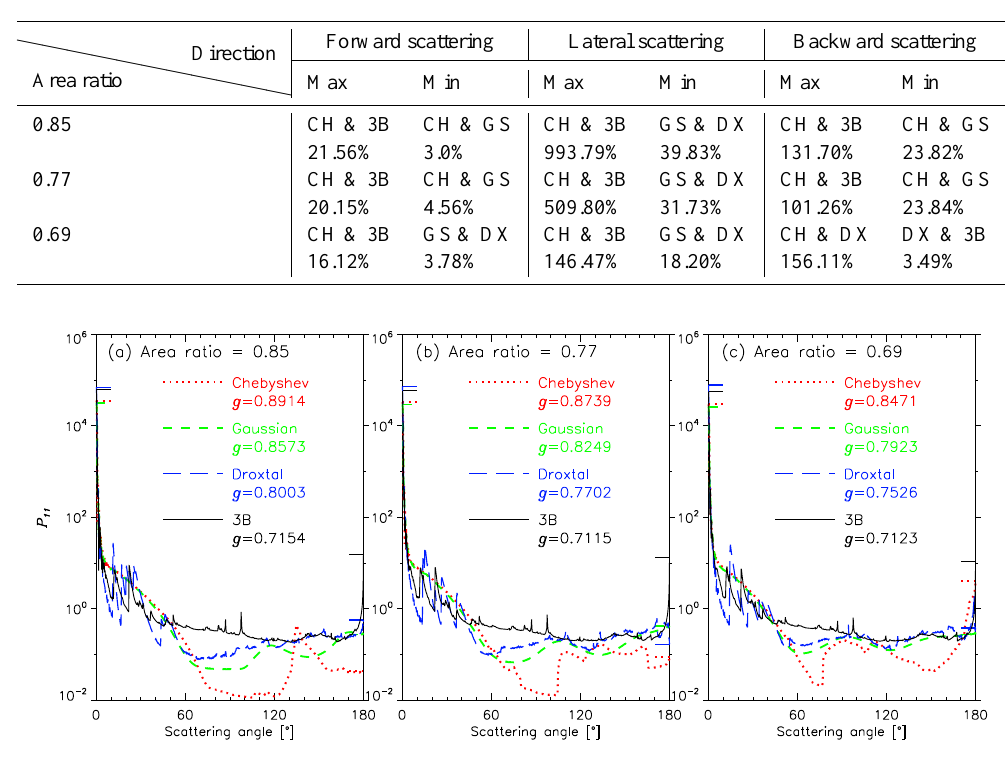
Table 1. Maximum and minimum difference in the forward, lateral, and backward scattering between a Chebyshev particle (CH), a Gaussian random sphere (GS), a droxtal (DX), and a budding Bucky ball (3B) for a given area ratio of small ice crystal. For a given area ratio and directional scattering, the maximum (Max) and minimum (Min) difference (%) are listed together with the names of the idealized models.